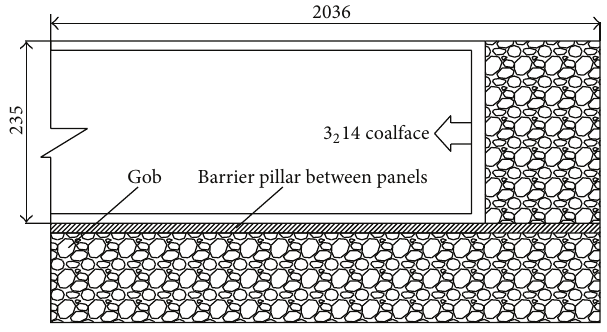
Figure 12: Layout of the 3 2 14 coalface and relevant